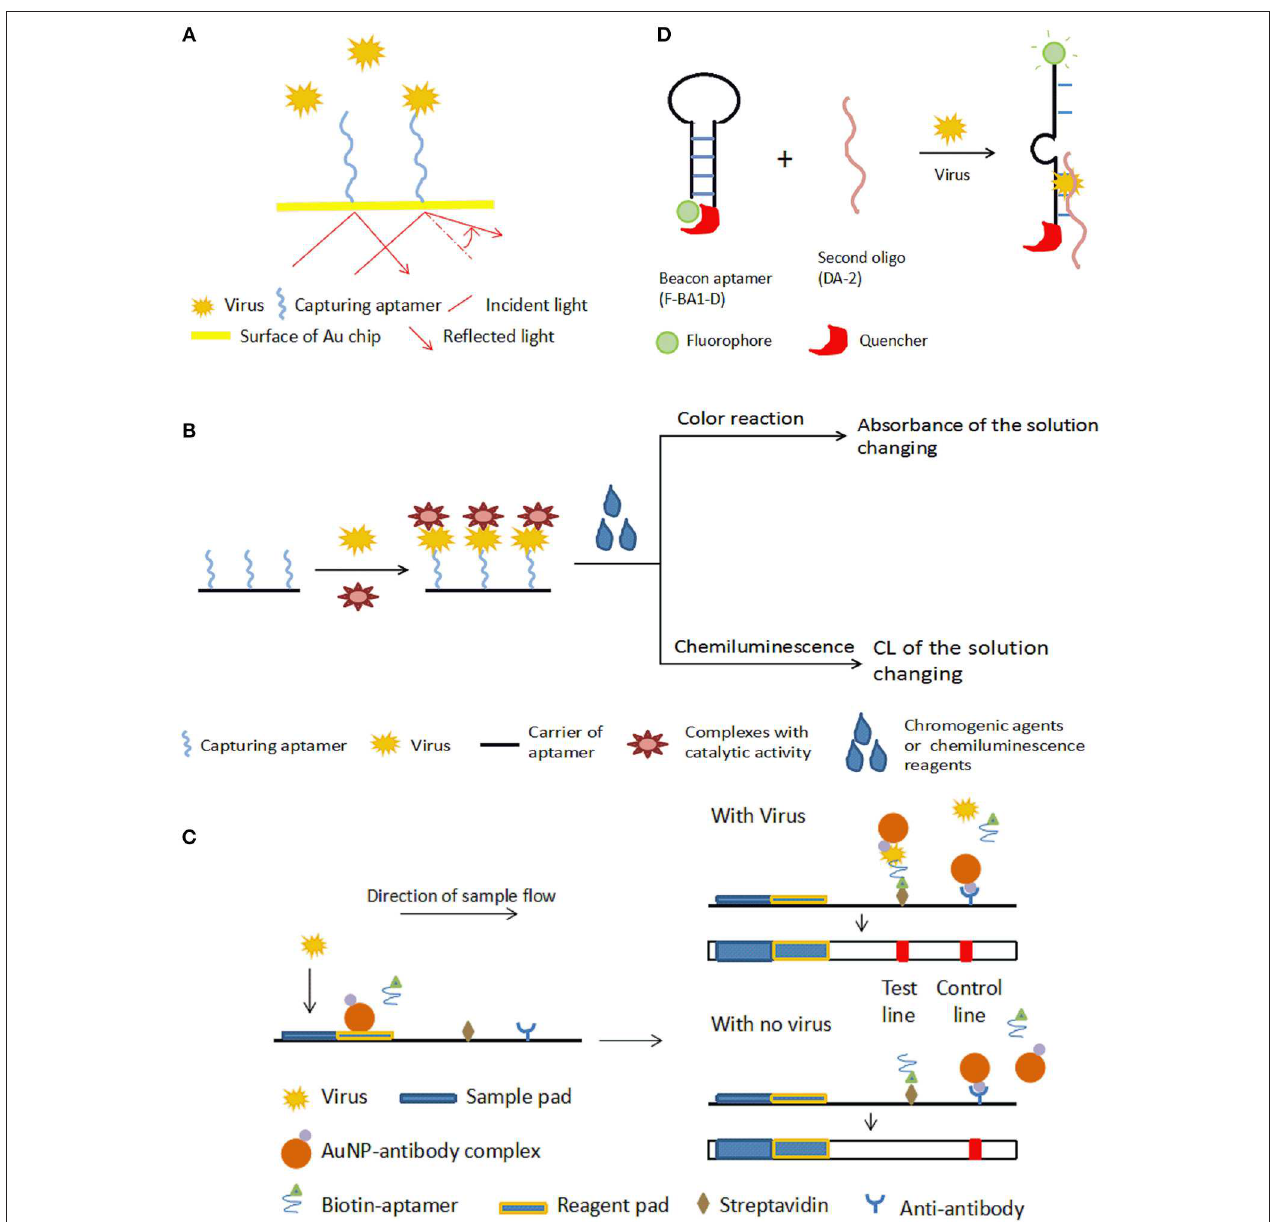
FIGURE 2 | Schematic illustration of optical aptasensors. (A) Mechanism of SPR aptasensors. The aptamer-virus interaction changes the angle of reflected light, which indicates the amount of virus captured by the aptamers. (B) Mechanism of typical colorimetric-based aptasensor and CL aptamers. The aptamer is incubated with the virus, then catalytic-active complexes that bind the captured virus are added. Appropriate chromogenic or CL reagents are added to affect the color or luminous intensity of the sample. The change in color or luminous intensity is correlated to the amount of virus in the sample. (C) Mechanism of LFA-based aptasensor. In the presence of the target virus, both the aptamer and the AuNP-antibody complex bind to the virus, and the biotin on the aptamer enables the complex to be bound onto the streptavidin on the test line, allowing detection by the color of GNPs. The color of the test line does not change if there is no target in the sample. With or without virus, the AuNP-antibody complex is caught by the anti-antibody on the control line to cause a color change as a control. (D) Mechanism of the fluorescent quench method. Target virus can bind with F-BA1-D and DA-2 and change the structure of F-BA1-D, separating the fluorophore and the quencher and releasing